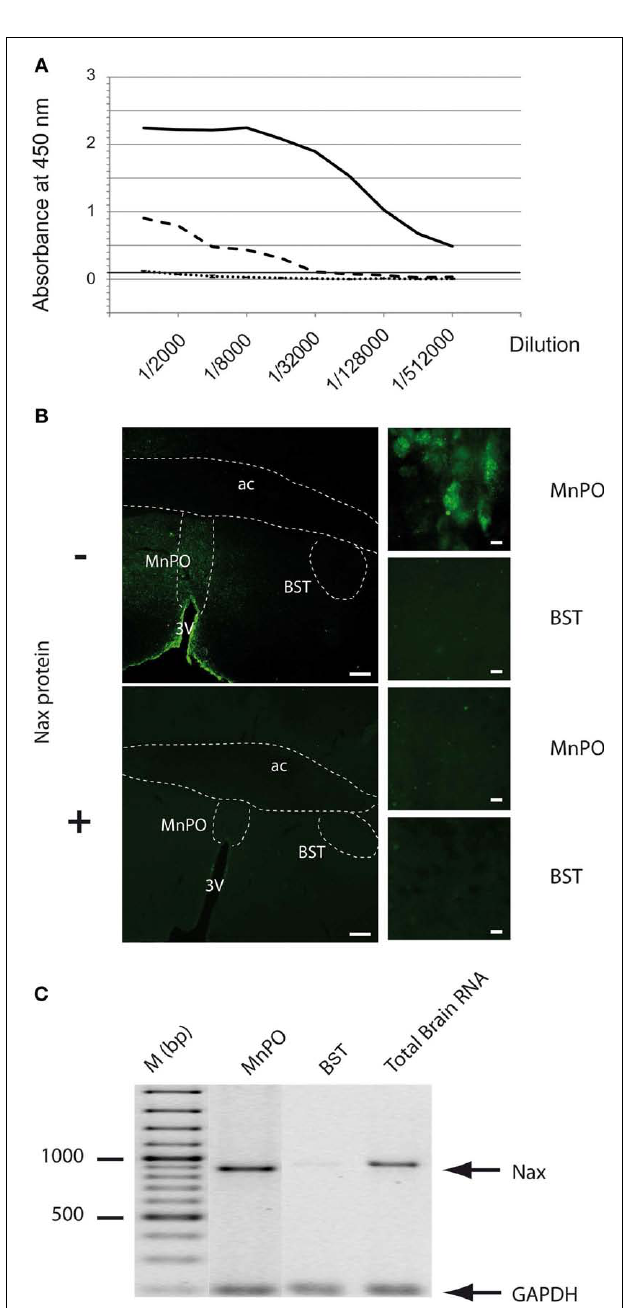
FIGURE 2 | Specificity and validation of the anti-Na X antibody. (A) The immune serum collected from the rabbits was assessed by ELISA and revealed the presence of the Na X protein and not the GST tag.The microplate was coated with the Na X peptide (1 µ g/well), incubated with pre-immune serum (dotted line), or double purified immune serum (black line: antibody titer >> 1/512,000).To control purification efficiency, ELISA was also performed on GST protein with double purified immune serum (dashed line).The rabbit antibodies were revealed with goat anti-rabbit IgG, HRP conjugated secondary antibody and the absorbance was read at 450nm. (B) The purified anti-Na X antibody (antibody concentration 1/250) was tested for immunohistochemical staining without ( − ) or with ( + ) preabsorption with the antigen peptide (50 µ g/ml). Fluorescent